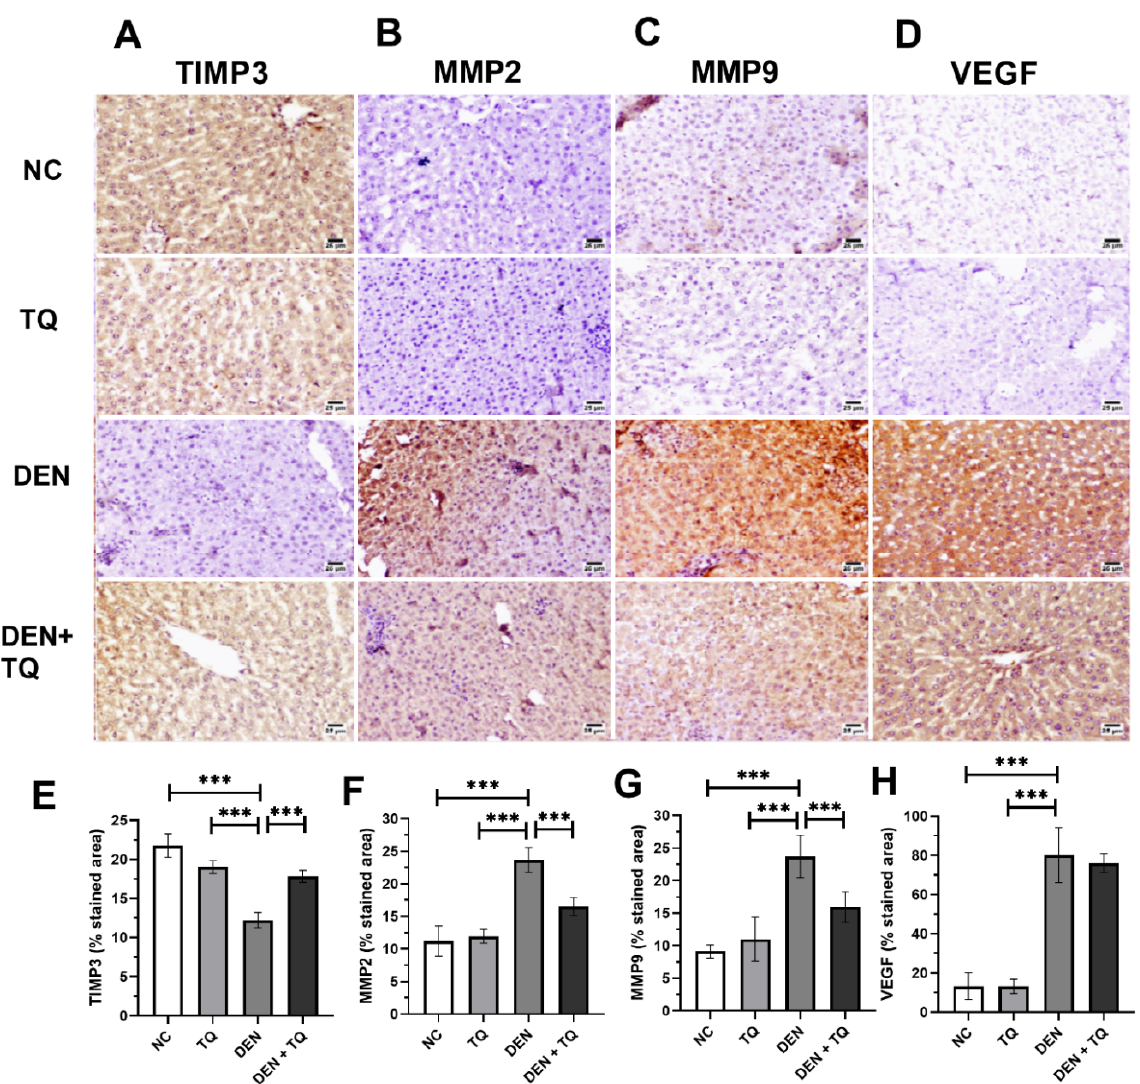
Figure 1. Immunohistochemical staining of rat liver for TIMP3 ( A ), MMP2 ( B ), MMP9 ( C ), and VEGF ( D ). ImageJ analysis and quantitation were done using % of stained area of TIMP3 ( E ), MMP2 ( F ), MMP9 ( G ), and VEGF ( H ), and illustrated by bar charts. Counterstaining was done with hematoxylin and the scale bar equals 25 µ m. One-way ANOVA and Tukey HSD as a post hoc test were used to compare the four groups *** significant at p < 0.0001. The experiments were performed in triplicates of 6 rats per each group and data are presented as mean ± standard